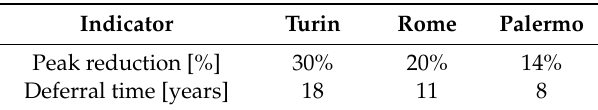
Table 15. Percentage reduction of the power peak with respect to scenario SC.0 and deferral time of strengthening measures in years. Indicator Turin